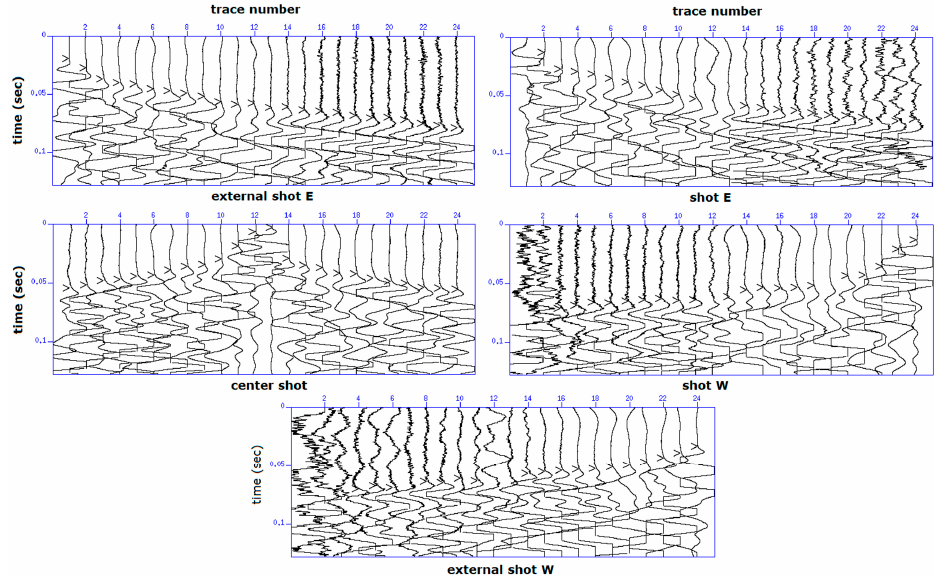
Figure 9. Seismograms from the C - C’ refraction line showing the picked travel-times.